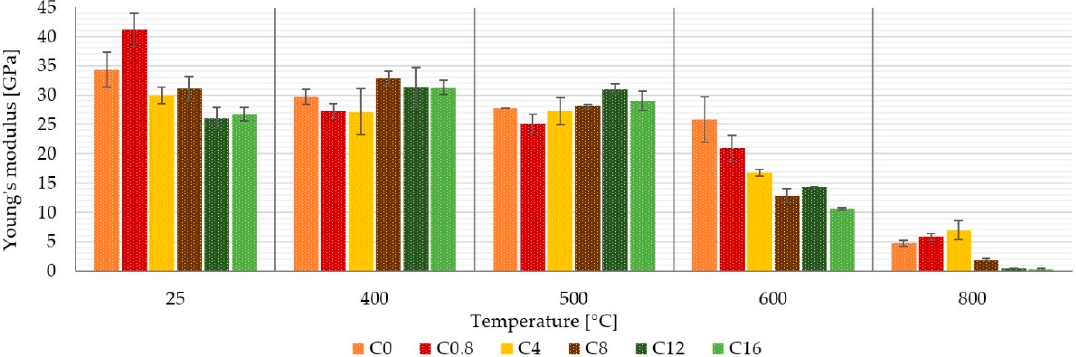
Figure 6. Influence of temperature and boron content in the matrix on the Young’s modulus of composites.